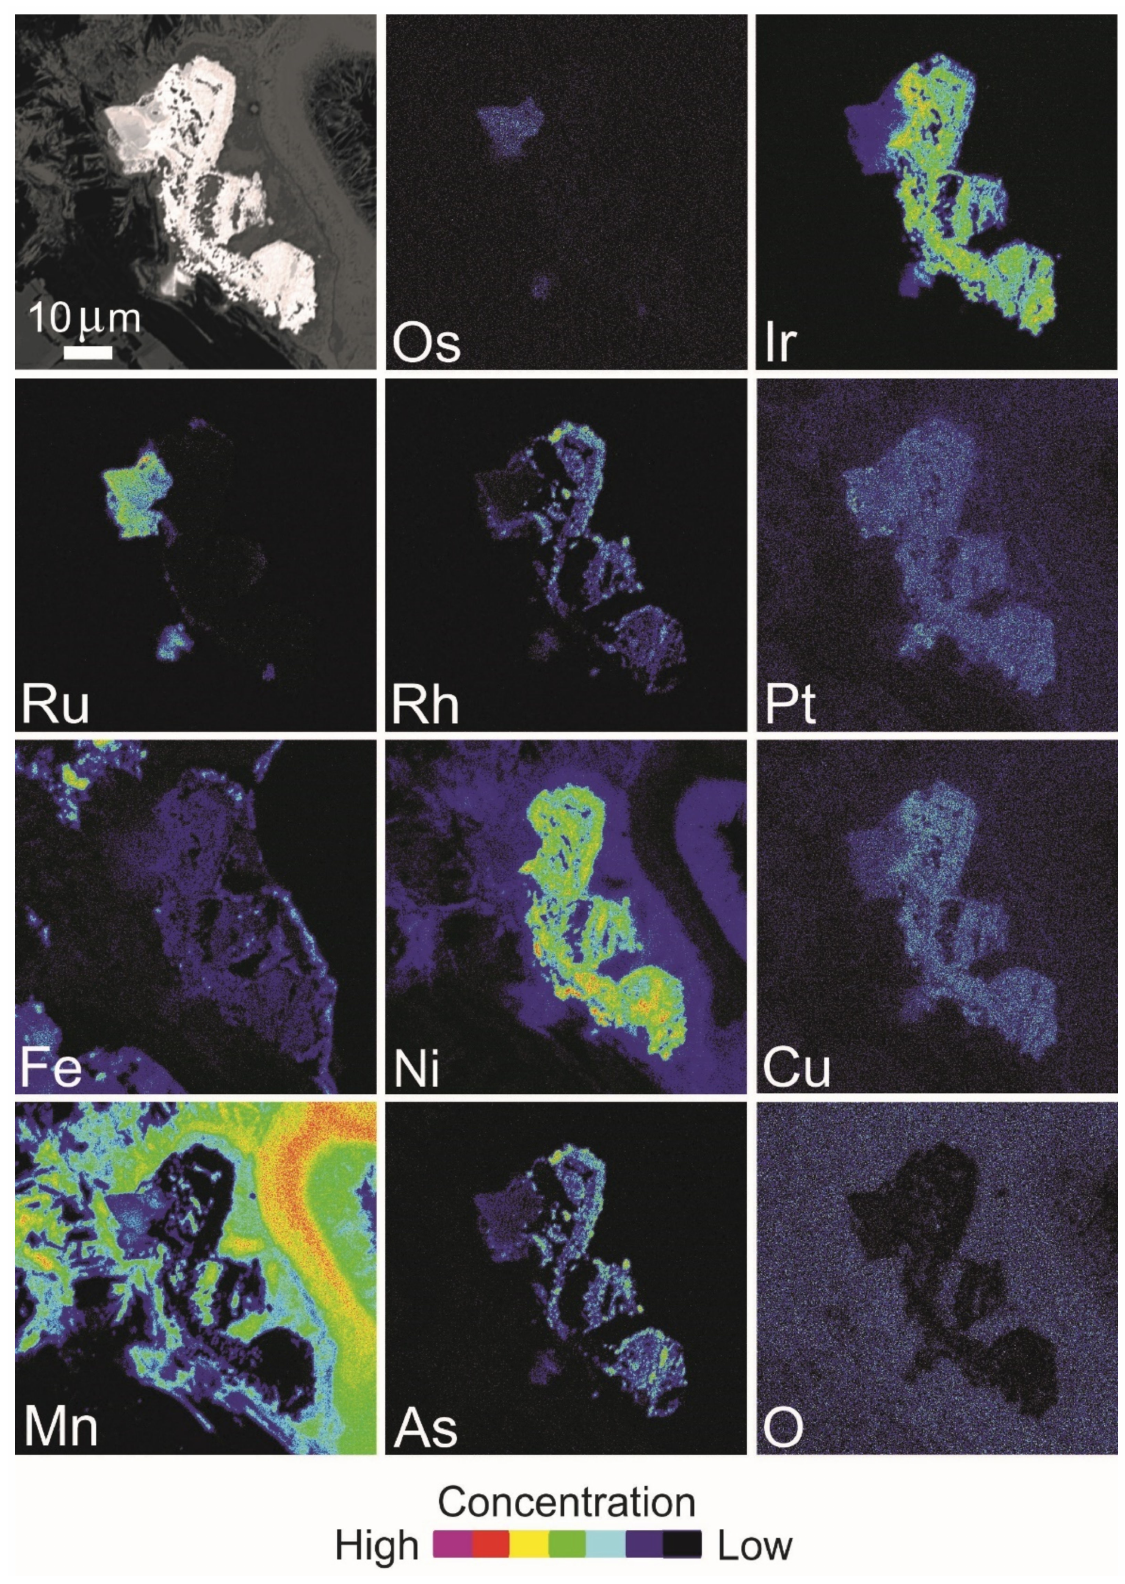
Figure 15. BSE image and X-ray elemental distribution maps of Os, Ir, Ru, Rh, Pt, Fe, Ni, Cu, Mn, As and O in the PGM shown in Figure 14A,B composed of garutiite–iridium–zaccariniite and a compound of